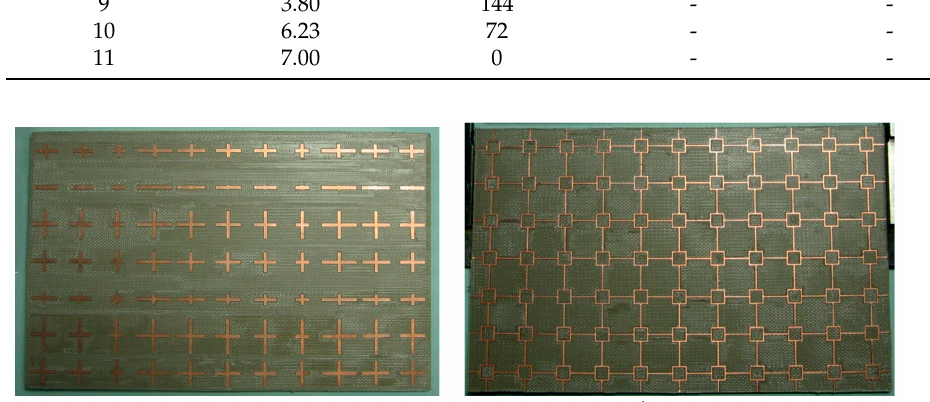
Figure 5. Photograph of a 7 × 11-element reflectarray using sandwiched FSS. ( a ) Top layer: cross- dipole elements layer. ( b ) Middle layer: Modified-loop FSS.